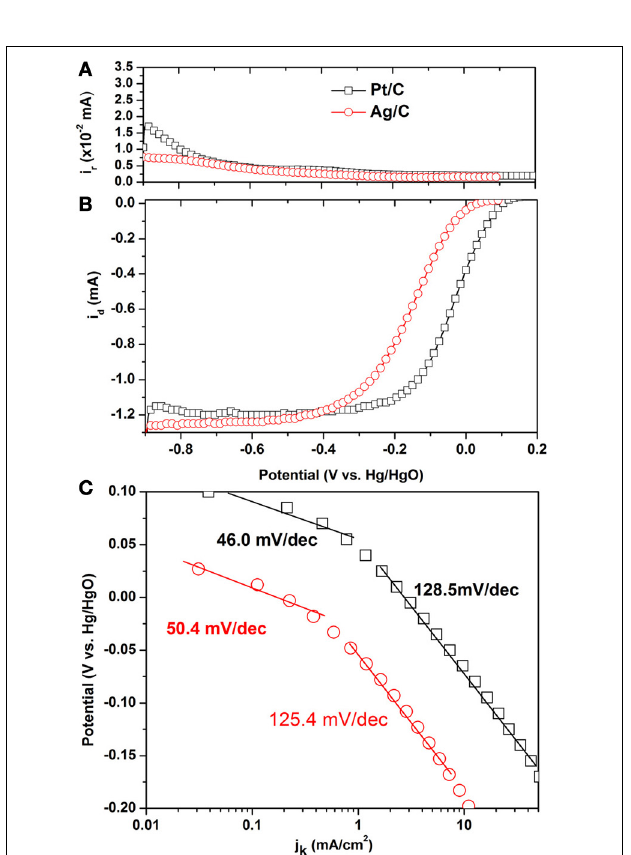
FIGURE 2 | Linear sweep voltammograms of Pt/C and Ag/C catalysts for the oxygen reduction reaction in O 2 -saturated 0.1M KOH. Scan rate: 10mV/s; rotation rate: 2500rpm; ring potential: 0.5V; collection efficiency: 0.23; room temperature. (A) Ring current; (B) Steady state polarization curves; (C) Tafel